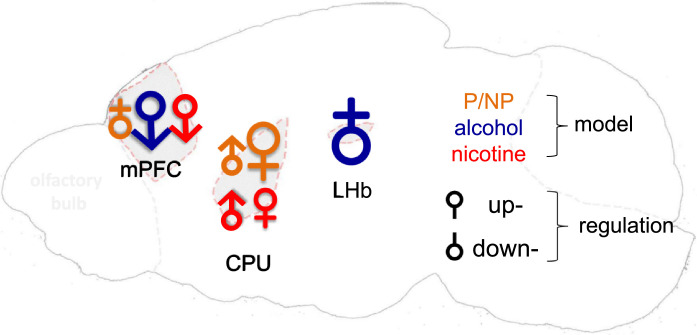
Summary of sex-dependences in model- and region-related Ppp1r12b mRNA levels. Symbol:♂ for male and ♀ for female; orientation of symbols, for up or down-regulation; size of symbol, extent of regulation (not to scale), in three regions (mPFC, CPU and LHb); different colours, different rodent models as indicated.